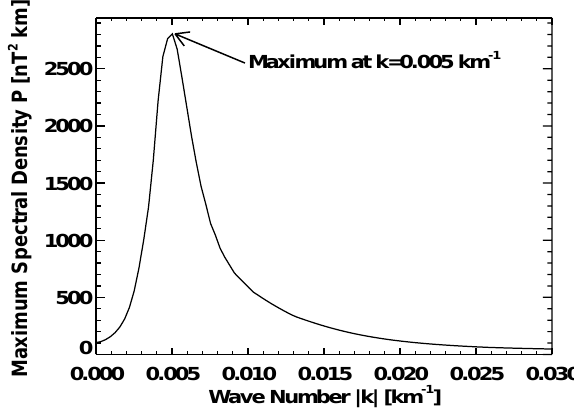
Fig. 5. Spatial wave spectrum at f = 0 . 133Hz.